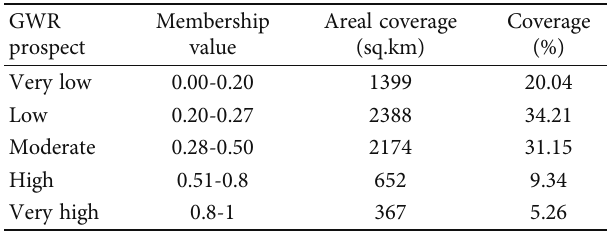
Table 9: Groundwater recharges classes, membership value, and distribution.